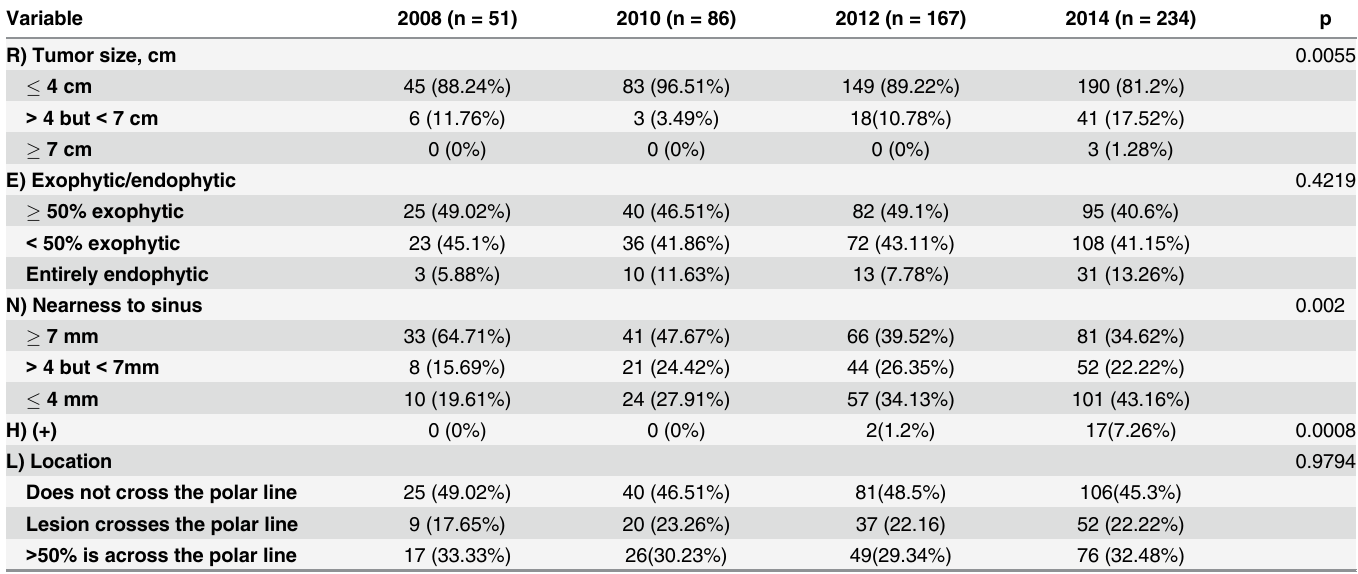
Table 2. Yearly proportional change of individual RNS components in the partial nephrectomy